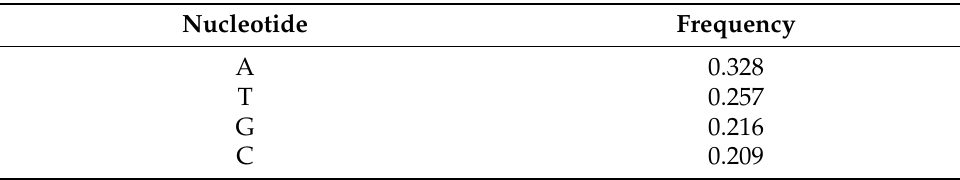
Table 4. Relative nucleotide frequency across fast sub-sequences.